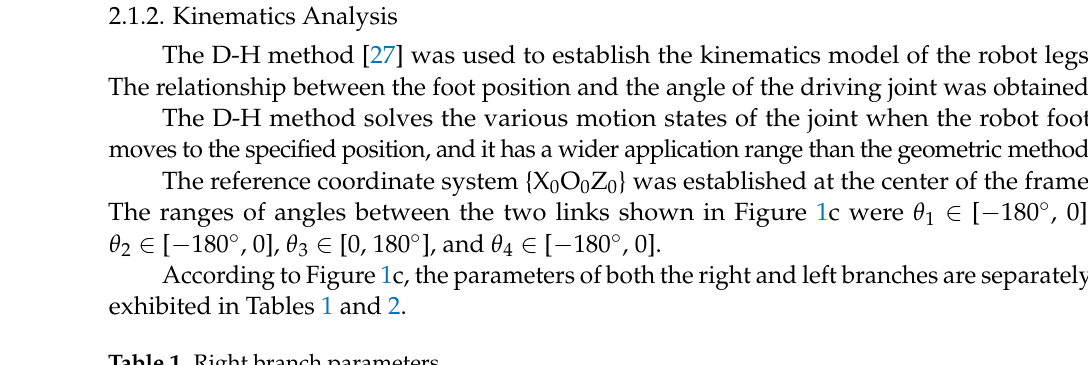
Table 1. Right branch parameters.